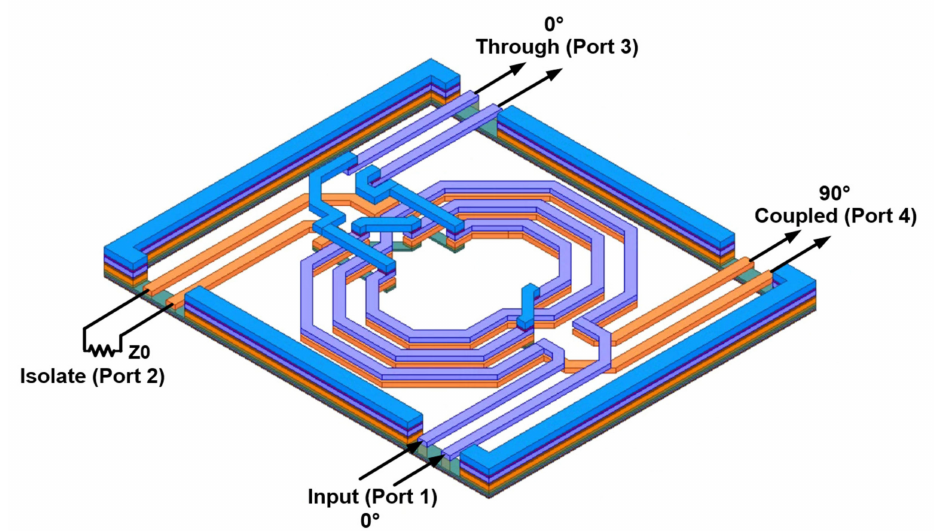
Figure 5. 3D EM model of the proposed transformer-based quadrature hybrid.